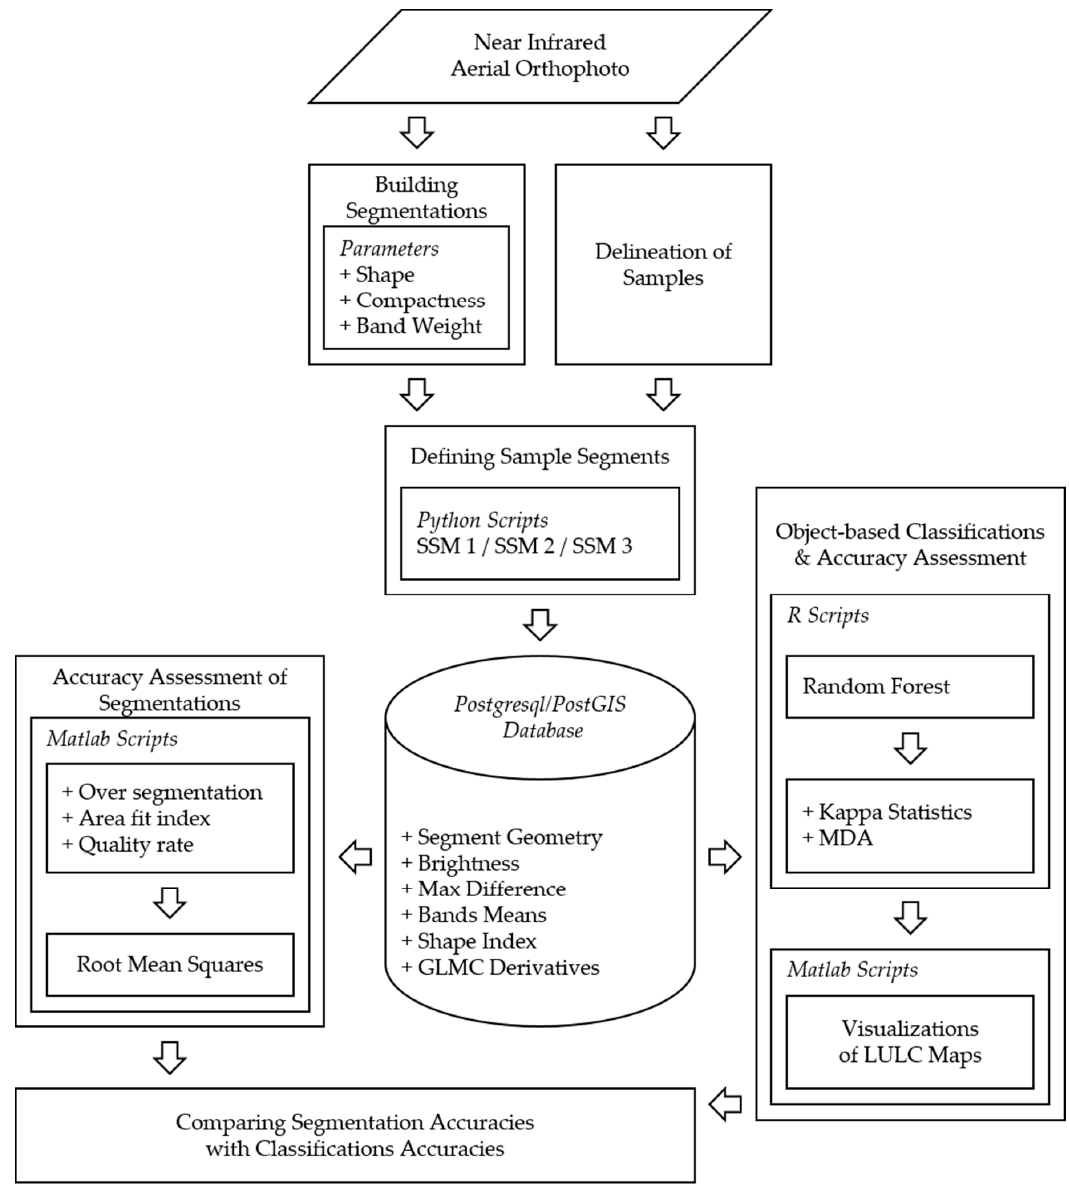
Figure 3. Workflow diagram.